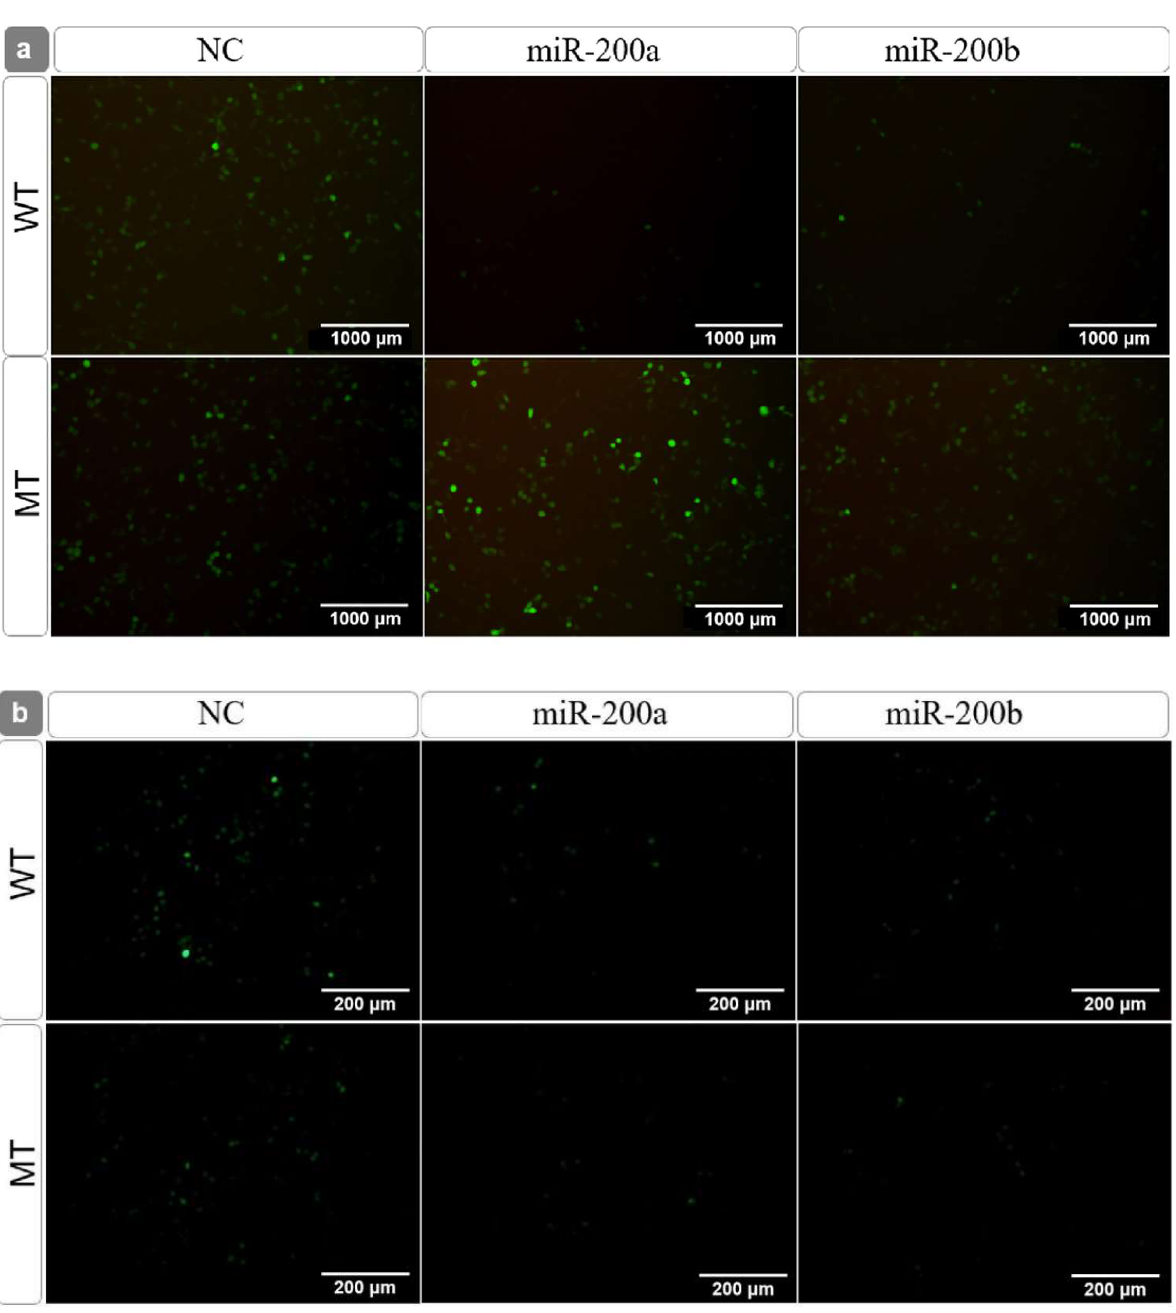
Figure 4. The luciferase activity of the wild and mutant recombinant reporter plasmid ( a ) site 1, ( b ) site 2). ** Indicates a statistically significant difference ( p < 0.01).